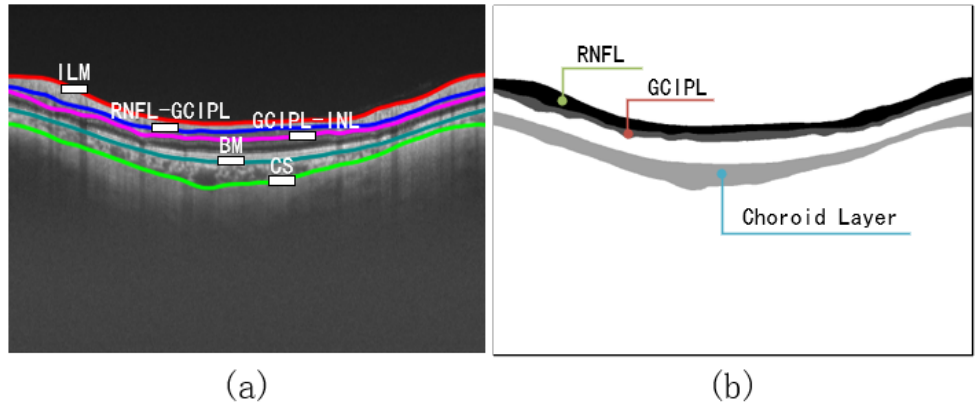
Figure 5. ( a ) OCT image with boundary naming. ( b ) Labels with instructions for retinal layers. The edge of each retinal layer in ( a ) is extracted from ( b ) using the Canny [33] algorithm.